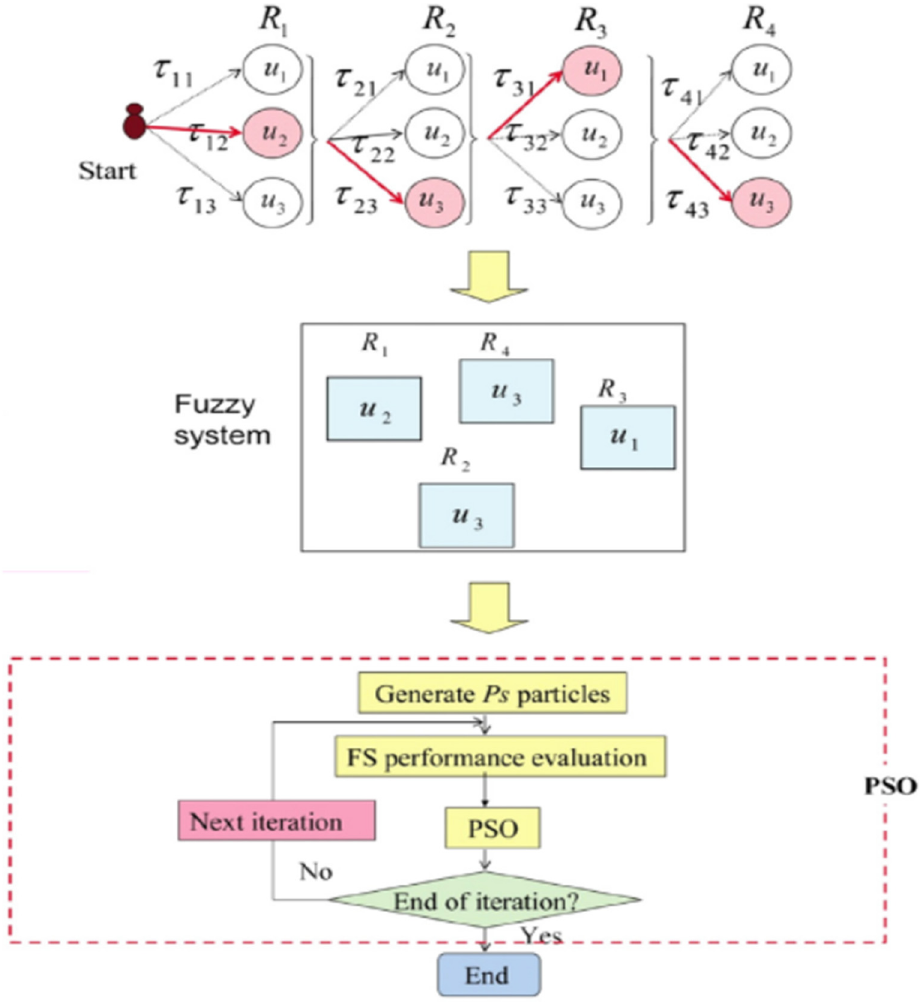
Figure 5. The flowchart of the ANFIS-PSO model. Reprinted with permission from ref [71] Published by Elsevier B.V.Copyright © 2015 Elsevier Ltd. All rights reserved [71].